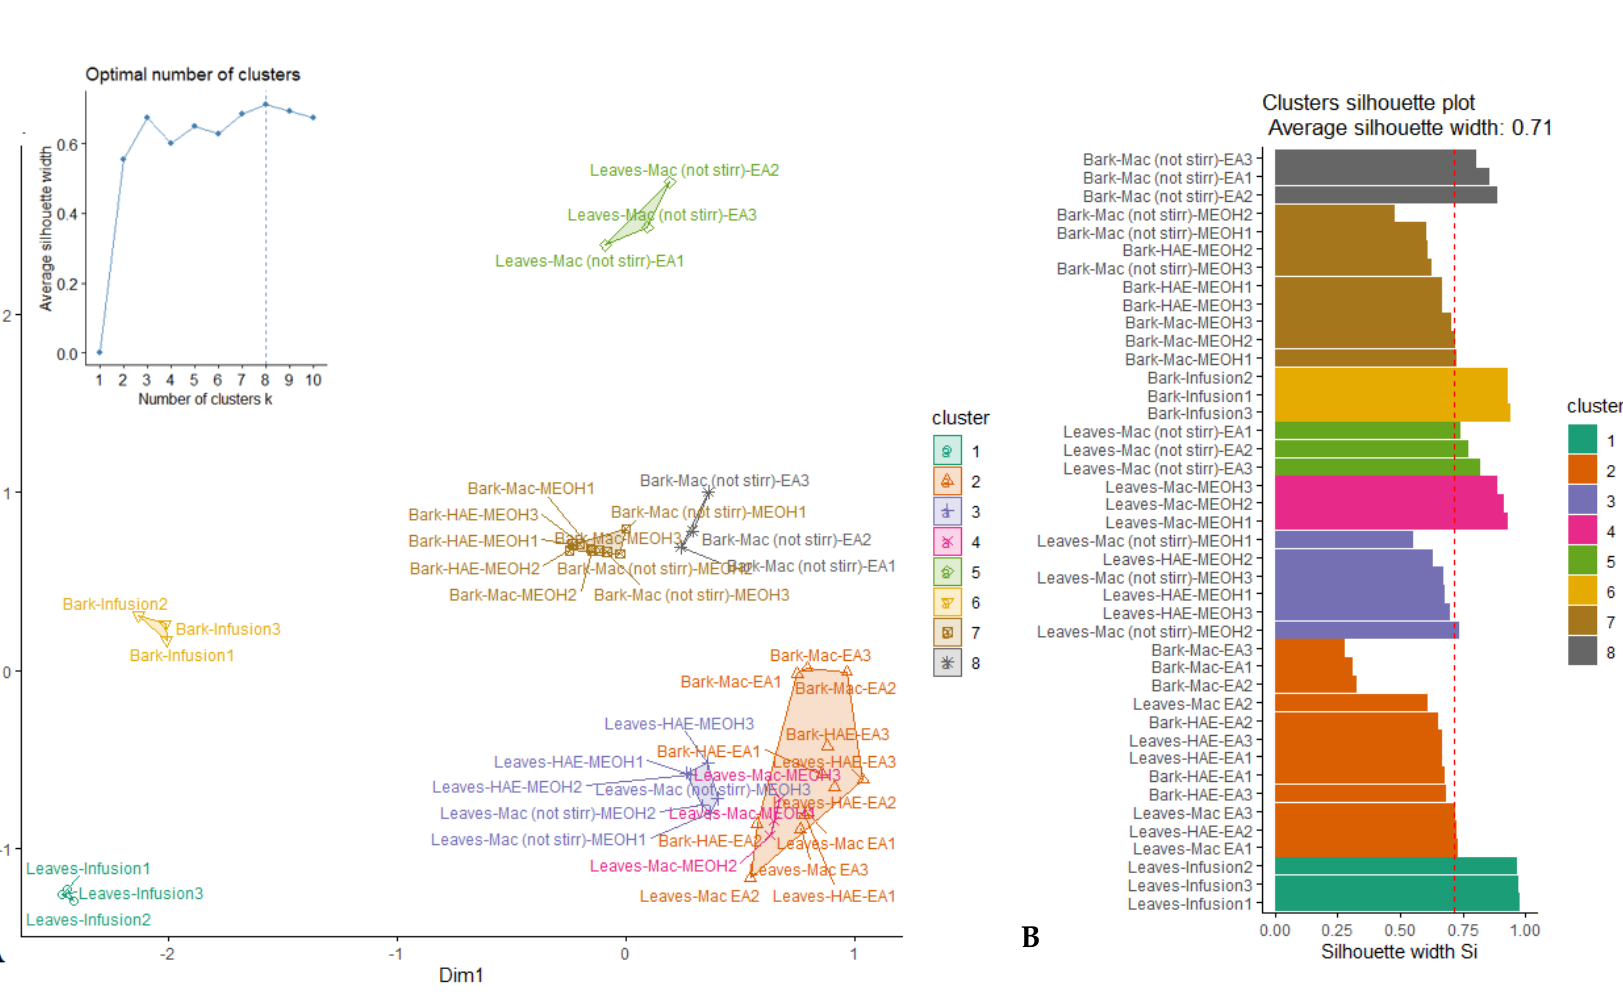
Figure 2. Cluster plot ( A ) and Silhouette plot ( B ) of K-medoids analysis.